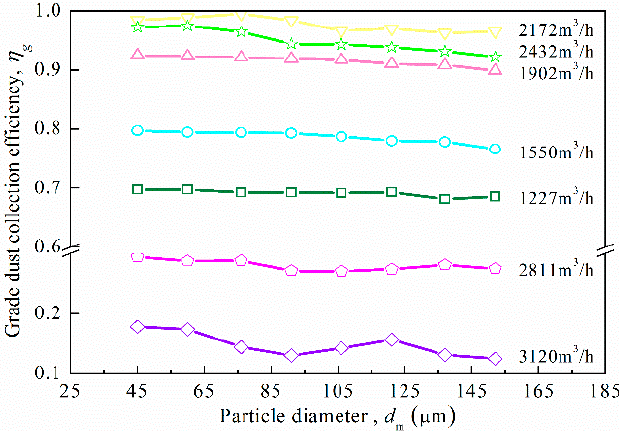
Figure 7. Influence of reverse-blowing flow rate on the grade dust-collection efficiency.